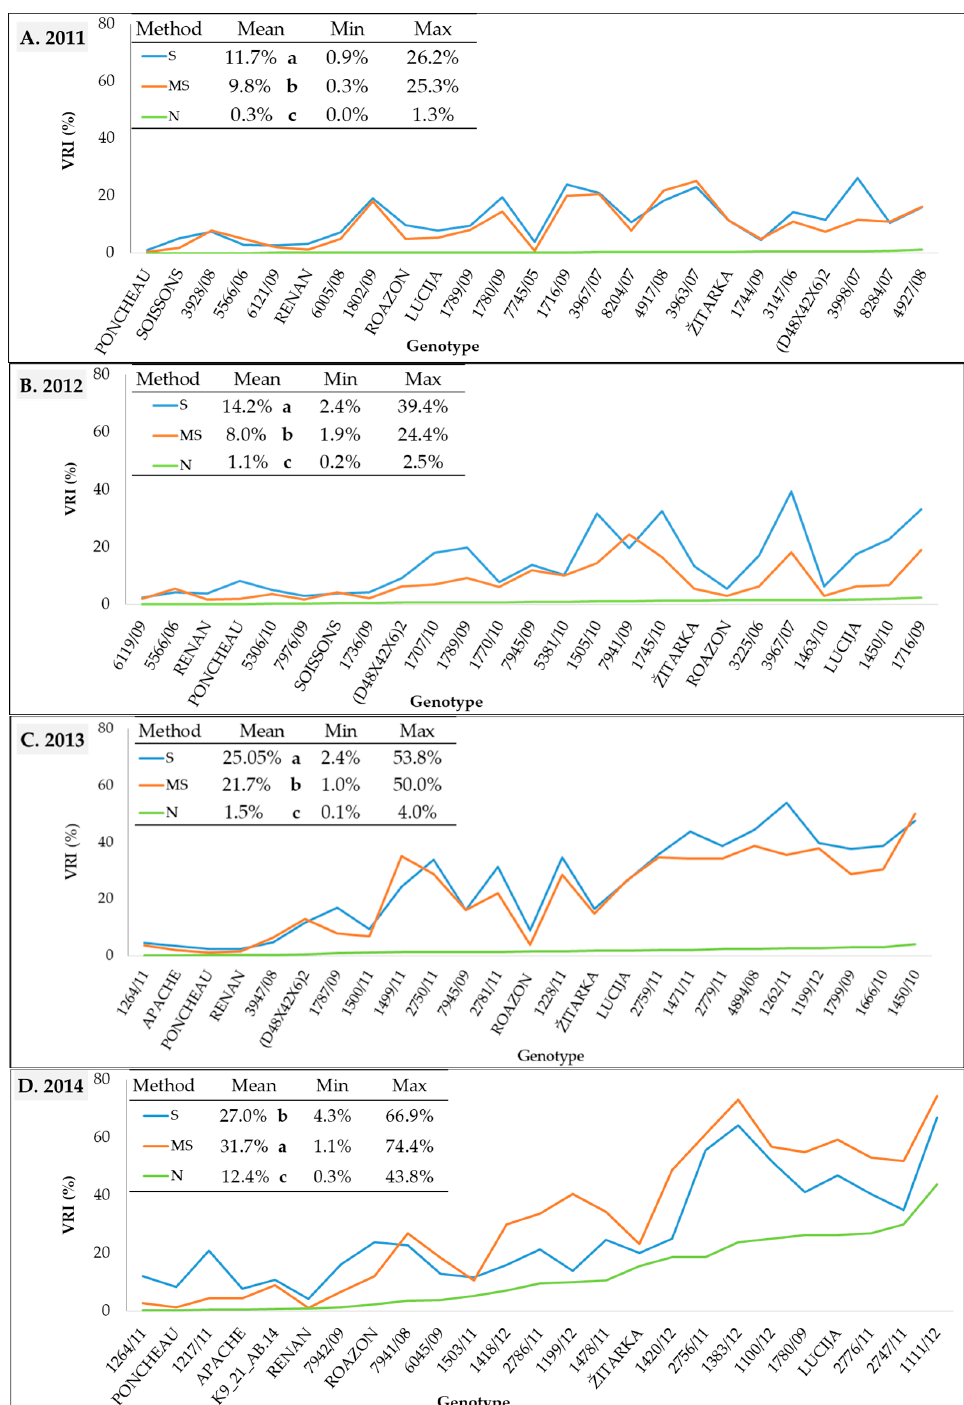
Figure 2. Visual rating index (VRI) in 25 wheat genotypes under spray inoculation (S), maize stalk inoculation (MS), and natural infection (N) in the ( A ) 2011, ( B ) 2012, ( C ) 2013, and ( D ) 2014 growing seasons. Means of the inoculation methods followed by the different letter are significantly different according to LSD test at p < 0.05.